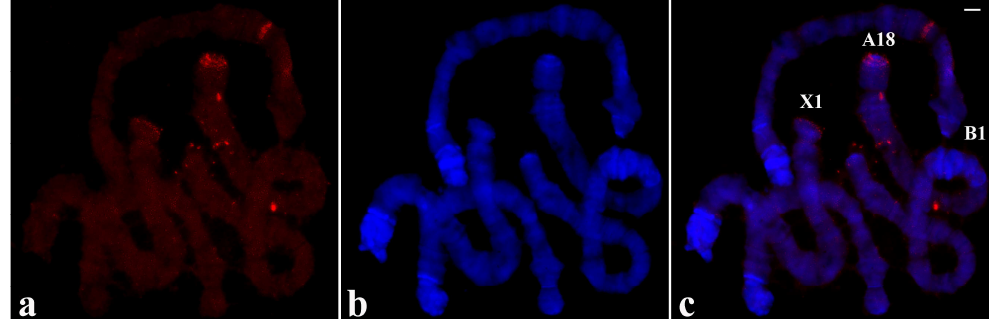
Figure 11. ( a ) Localization of the p Tp -2.1 probe (red signal) in chromosomes of R.americana. ( b ) The same chromosomes stained with DAPI and ( c ) the merged hybridization and DAPI signals. Chromosome tips identified in the figure show the probe labelling restricted to A-18 and X-1. Bar = 15 µ